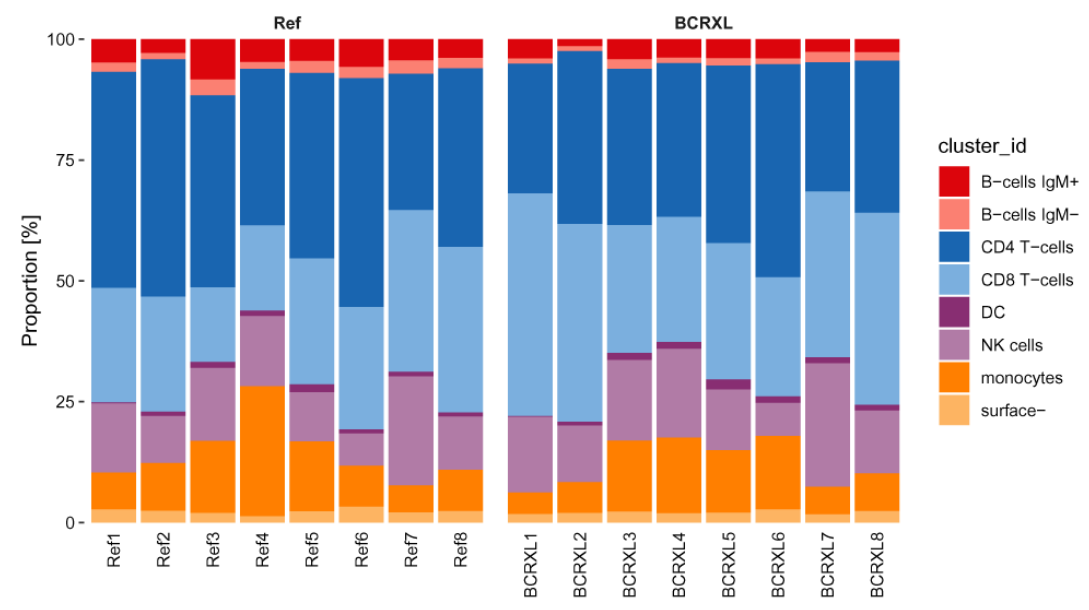
Figure 20. Relative abundance of the 8 PBMC populations in each sample (x-axis), in the PBMC dataset, represented with a barplot. The 8 cell populations are a result of manual merging of the 20 FlowSOM